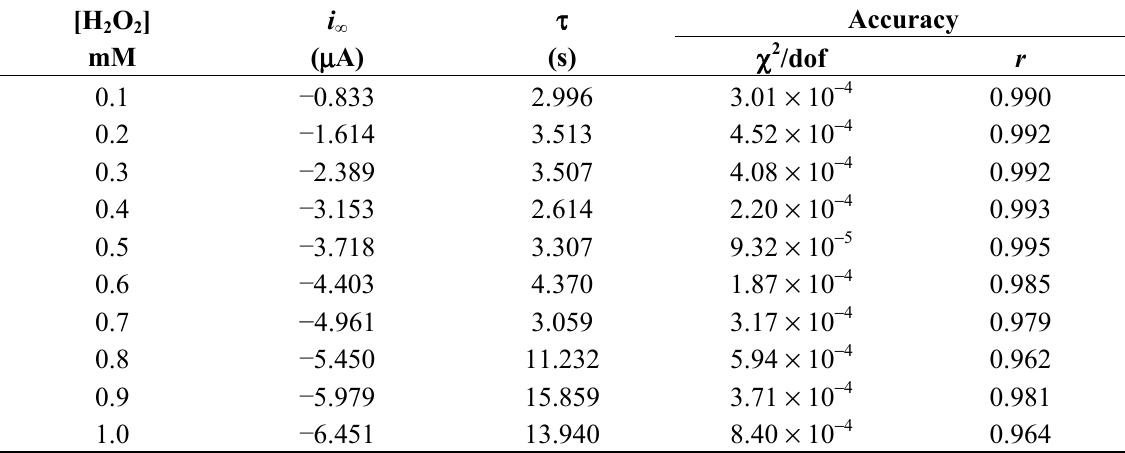
) and pre-steady-state relaxation time ( τ ) at different ∞ O 2 2